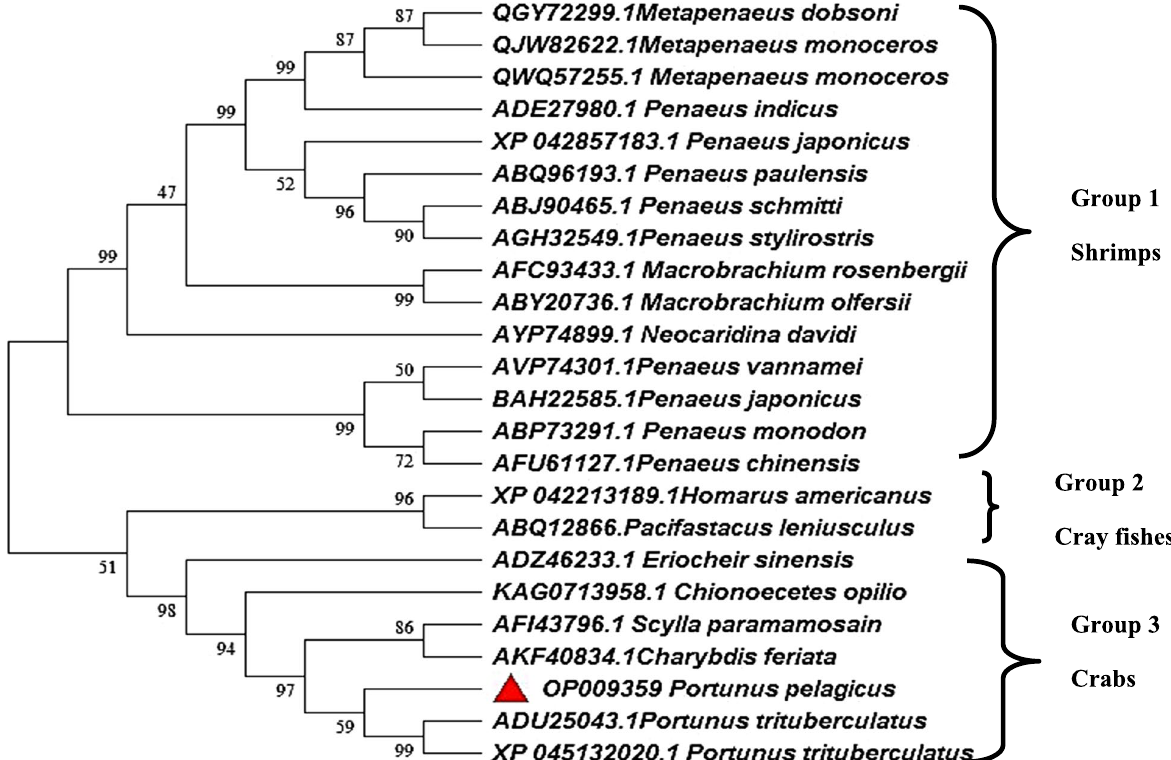
Fig. 5 Maximum likelihood tree obtained using MEGA 7 showing the phylogenetic relationship of Pp -ALF with other crustacean